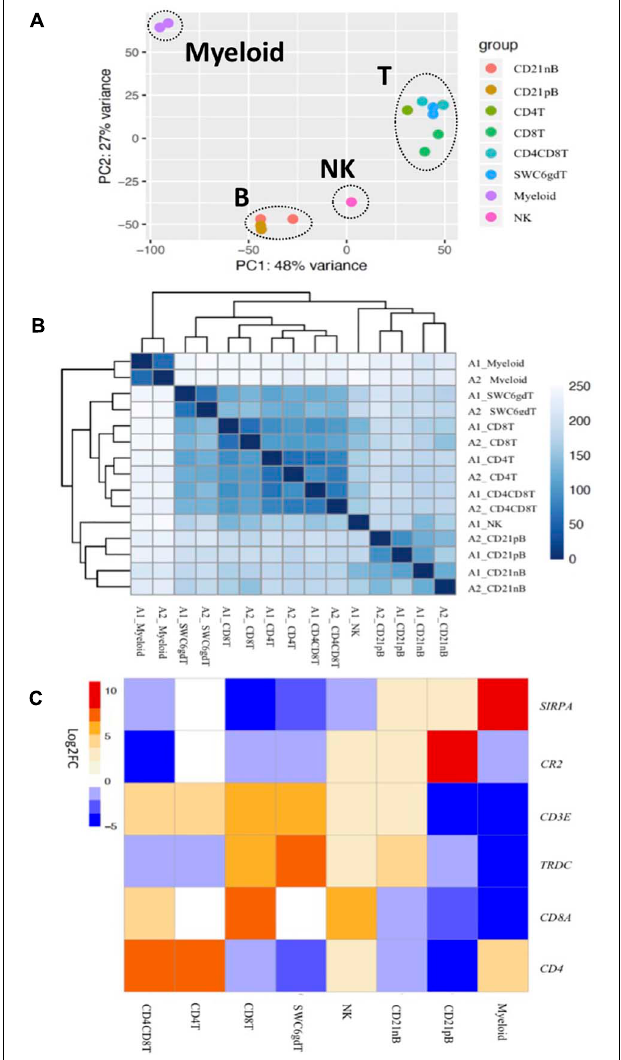
FIGURE 2 | Transcriptional expression patterns of immune cells are distinct and cluster more by progenitors. (A) Principal component analysis of transformed RNA-seq reads counts for whole transcriptomes. Axis indicate component scores. (B) Heat map depicting hierarchical clustering of sample-to-sample distance. Gene expression for whole transcriptomes were used to calculate sample to sample Euclidean distance (color scale) for hierarchical clustering. (C) Heatmap showing cell-type enriched gene values (Log2FC) between sorted immune cells. Gene coding proteins that were used for cell sorting were